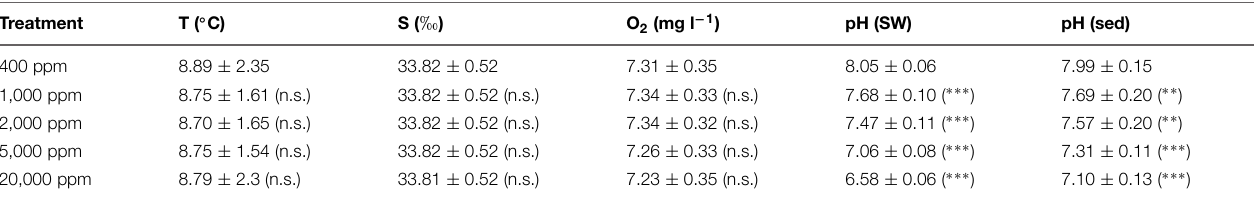
TABLE 1 | Temperature (T), salinity (S), oxygen concentration (O 2 ), and pH in the seawater (SW) and sediment (Sed) in the different high-CO 2 experimental systems (1,000–20,000 ppm) and in the controls (i.e., 400 ppm), reporting mean values and ranges. Treatment